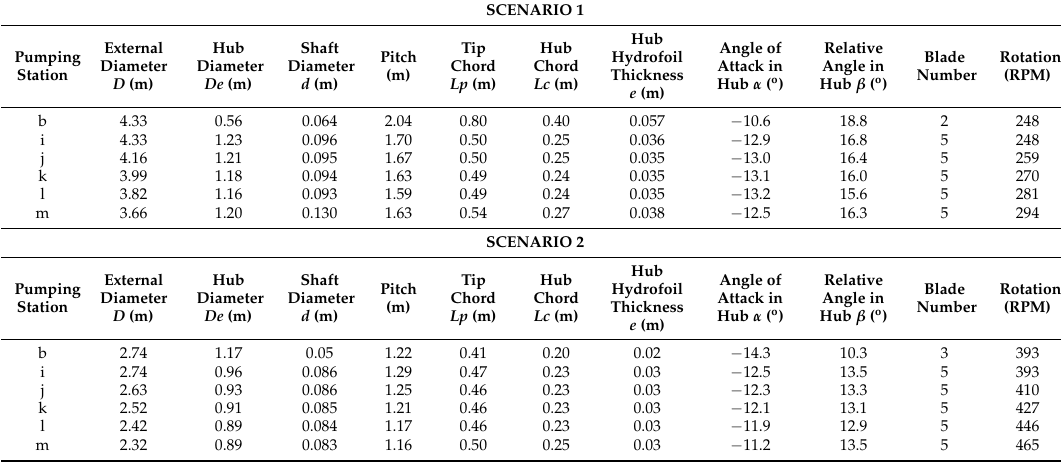
Table 7. Dimensions of the axial pumps for underwater pipelines Parna í ba/Fortaleza, Brazil. Scenario 1 (200 L/capita/day), Scenario 2 (81 L/capita/day).